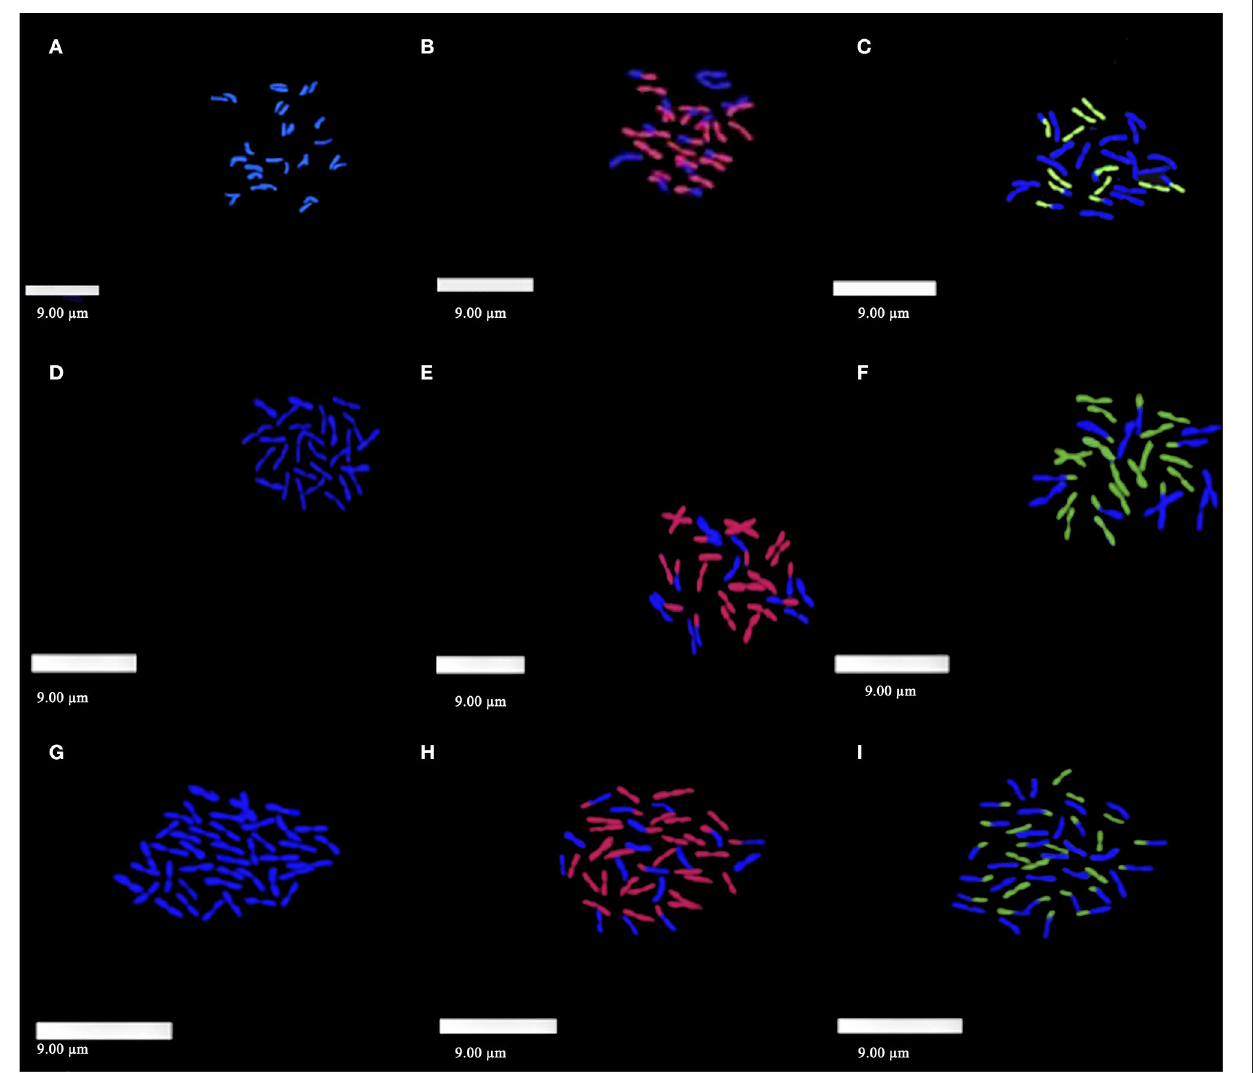
FIGURE 4 | Genomic in situ hybridization on somatic metaphase cells from root tips of E. nutans , E. burchan-buddae , and E. sibiricus , with Pseudoroegneria strigosa and H. bogdanii as probes. (A–C) E. burchan-buddae . (A) Twenty-eight chromosomes counterstained by DAPI on metaphase; (B) 24 chromosomes showed red fluorescence when probing with St-genome DNA of P. strigosa ; (C) 12 chromosomes showed green fluorescence when probing with H-genome DNA of H. bogdanii . (D–F) E. sibiricus . (D) Twenty-eight chromosomes counterstained by DAPI on metaphase; (E) 22 chromosomes showed red fluorescence when probing with St-genome DNA of P. strigosa ; (F) 22 chromosomes showed green fluorescence when probing with H-genome DNA of H. bogdanii . (G–I) E. nutans . (G) Forty-two chromosomes counterstained by DAPI on metaphase; (H) 32 chromosomes showed red fluorescence when probing with St-genome DNA of P. strigosa ; (I) 26 chromosomes showed green fluorescence when probing with H-genome DNA of H. bogdanii